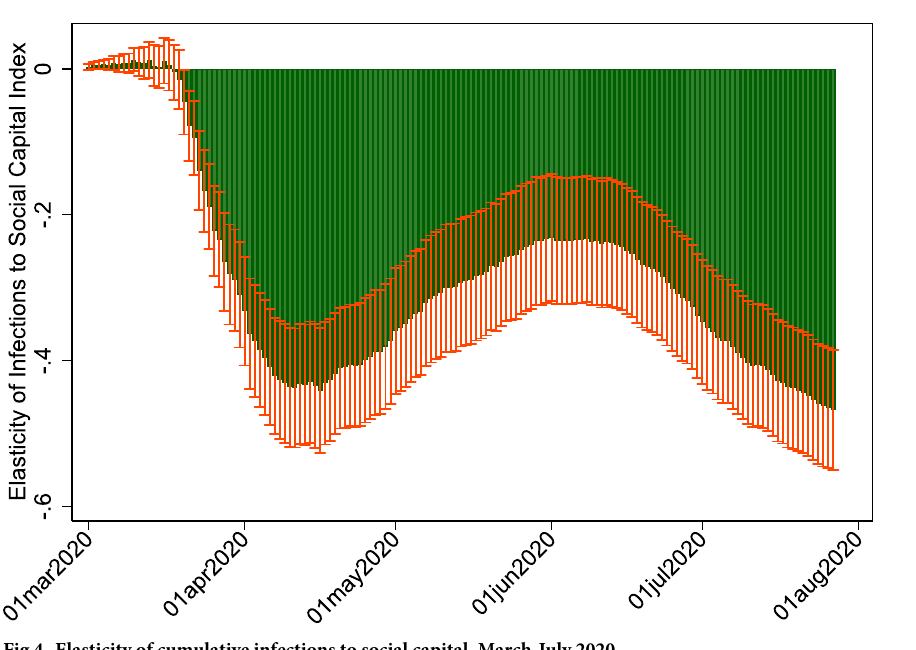
Fig 4. Elasticity of cumulative infections to social capital, March-July